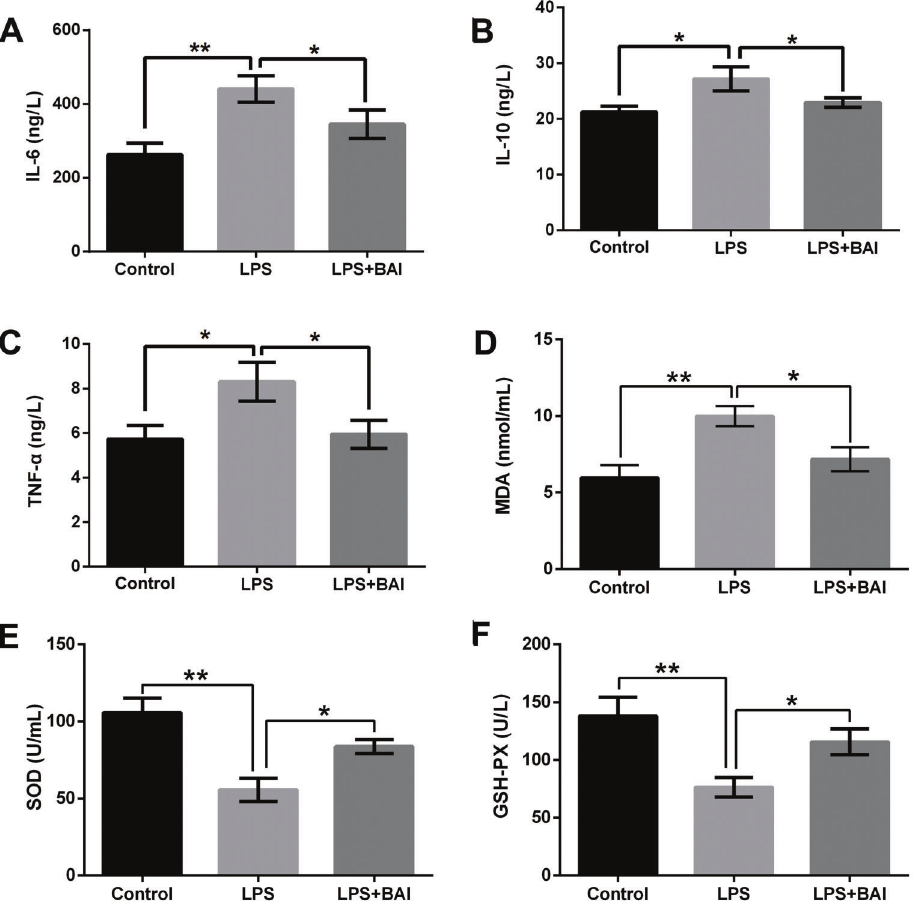
Figure 2. Effect of BAI in LPS-induced RPTECs in A , IL-6 expression; B , IL-10 expression; C , TNF- a expression; D , MDA activity; E , SOD activity; F , GSH-PX activity. BAI: baicalein; LPS: lipopolysaccharide; RPTECs: renal proximal tubular epithelial cells; IL-6: interleukin-6; IL-10: interleukin-10; TNF- a : tumor necrosis factor- a ; MDA: malondialdehyde; SOD: superoxide dismutase; GSH-PX: glutathione peroxidase. Data are reported as means ± SE. *P o 0.05; **P o 0.01